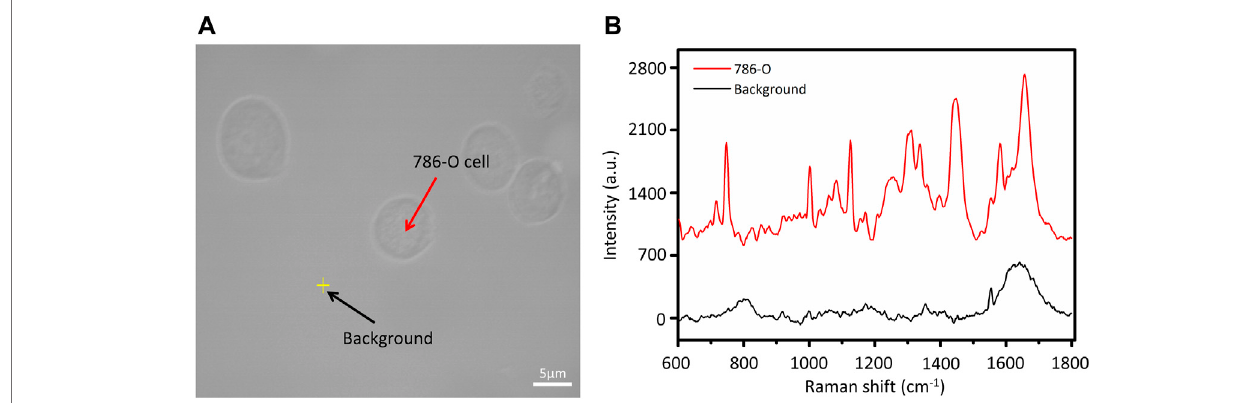
FIGURE 2 | The average Raman spectra of 6 kinds of cells with error bars.